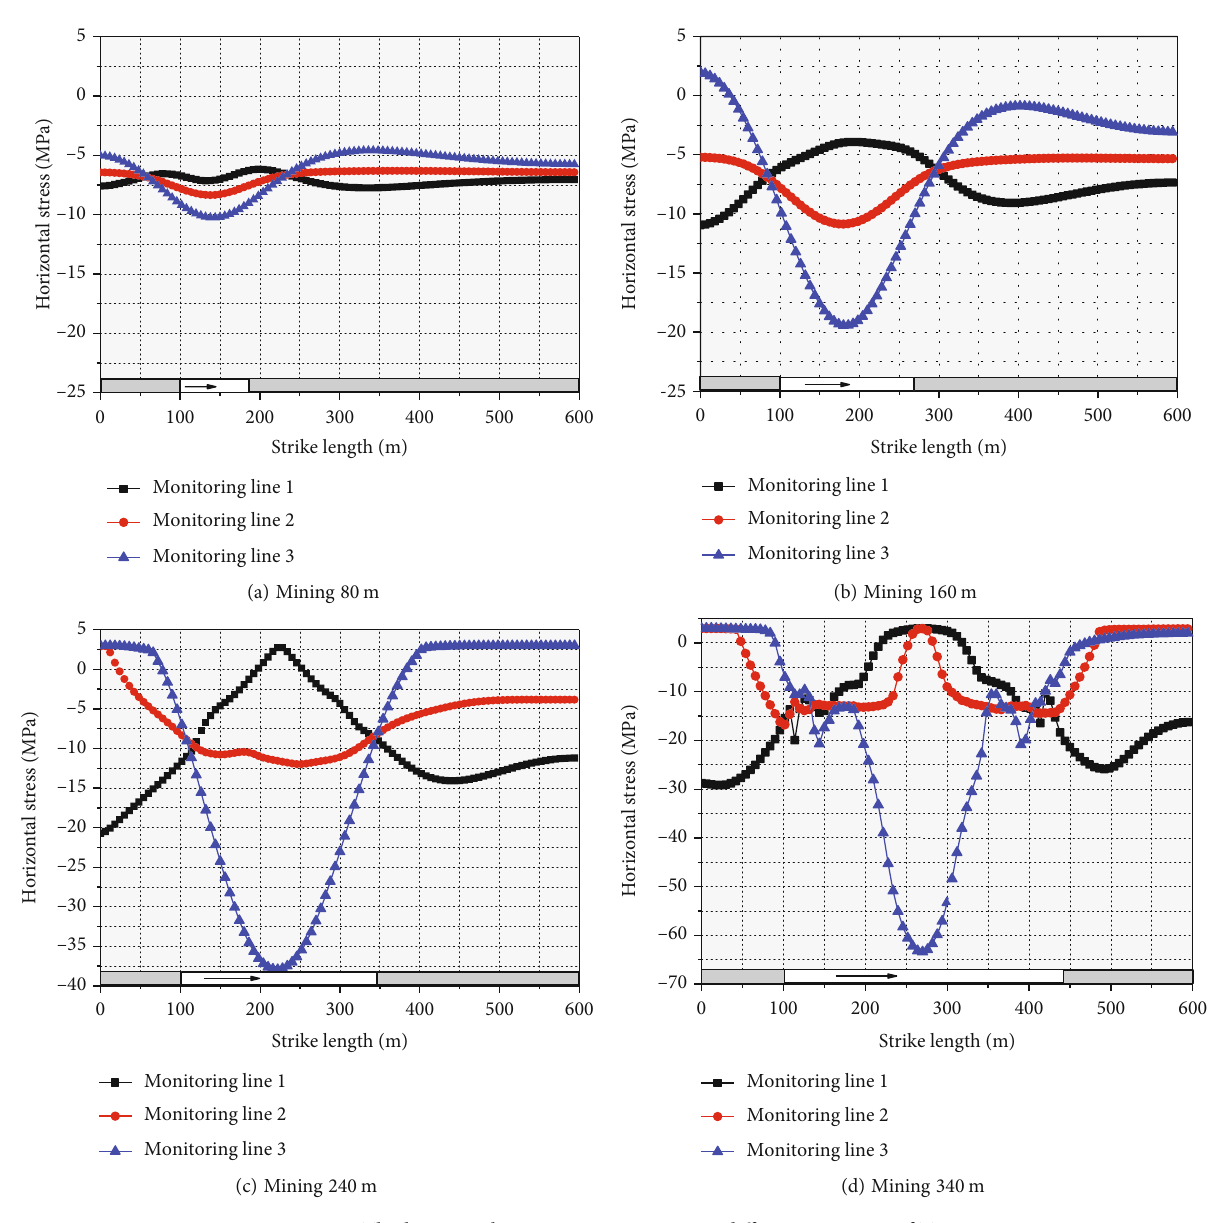
Figure 14: The horizontal stress variation curve at di ff erent positions of